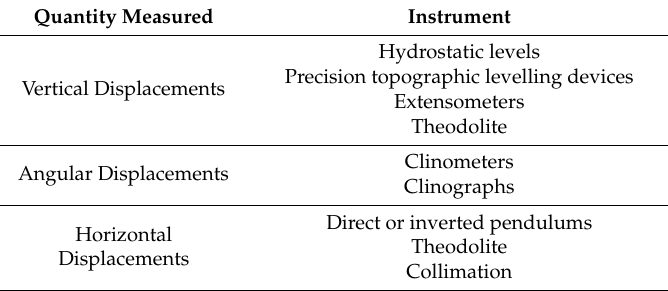
Table 2. Typical instrumentation used to monitor displacements of the